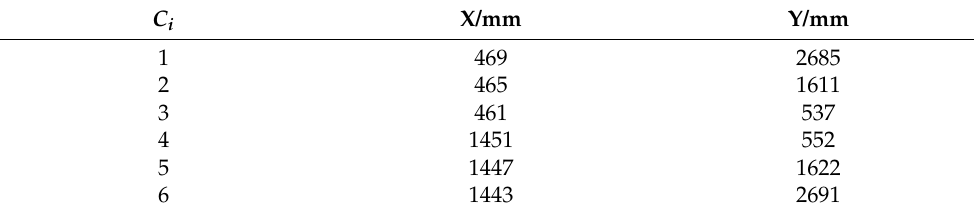
Figure 29. The partition model of the target points. Table 2. The center point C i .